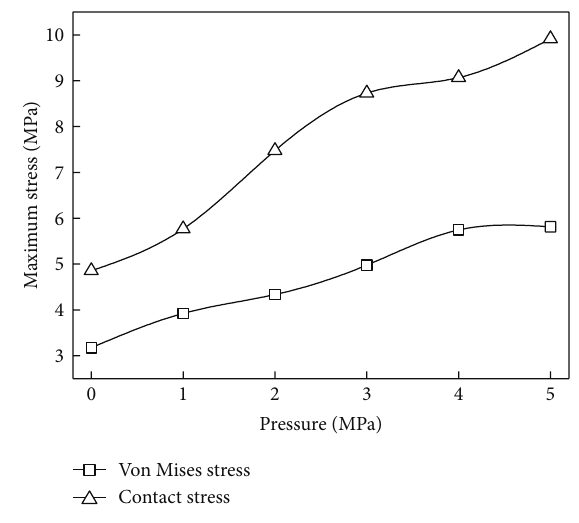
Figure 11: Stress of the biomimetic sealing ring under different medium